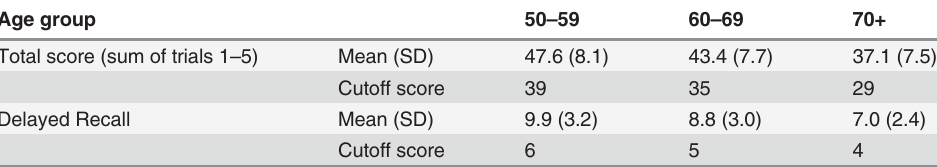
Table 3. Rey Auditory Verbal Learning Test (RAVLT): normative data and cut-off scores for Mild Cognitive Impairment